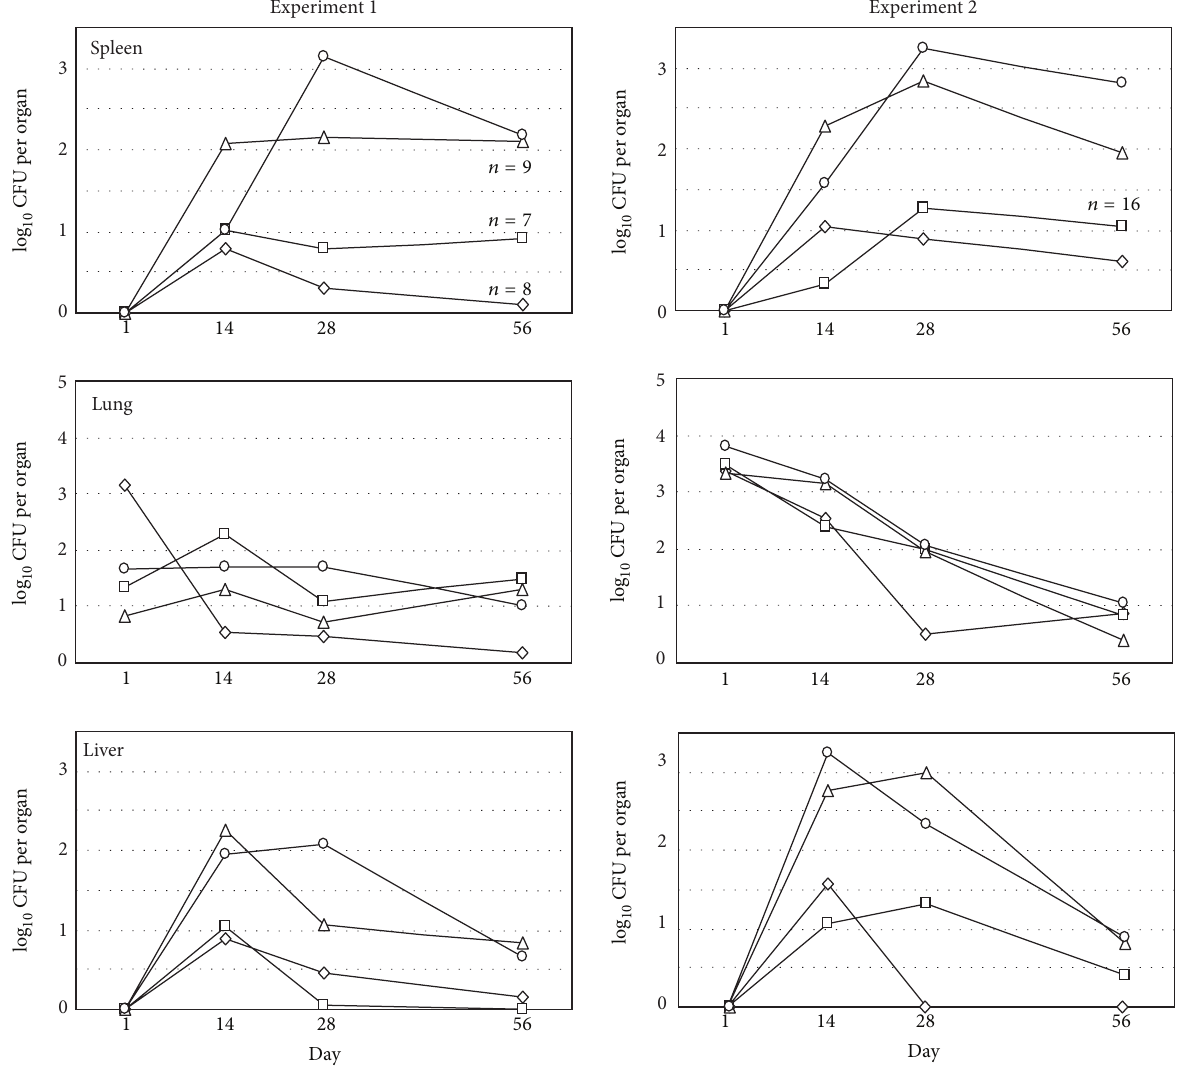
Figure 1: Immunization and challenge. Six-week-old male C57BL/6 and CD8 knockout mice were orally immunized with 10 11 WR201 and eight weeks later challenged with 10 4 B. melitensis 16M. Data points represent mean CFU per organ (limit of detection = 2) for 4-5mice (first three time points) and 10 mice (56-day time point) except where noted. The figure shows naive CD8 knockout mice (circles), naive C57BL/6 mice (triangles), immune CD8 knockout mice (squares), and immune C57BL/6mice (diamonds). In no case did mice of the same immunization status have significantly different CFU levels at a given time point in a given